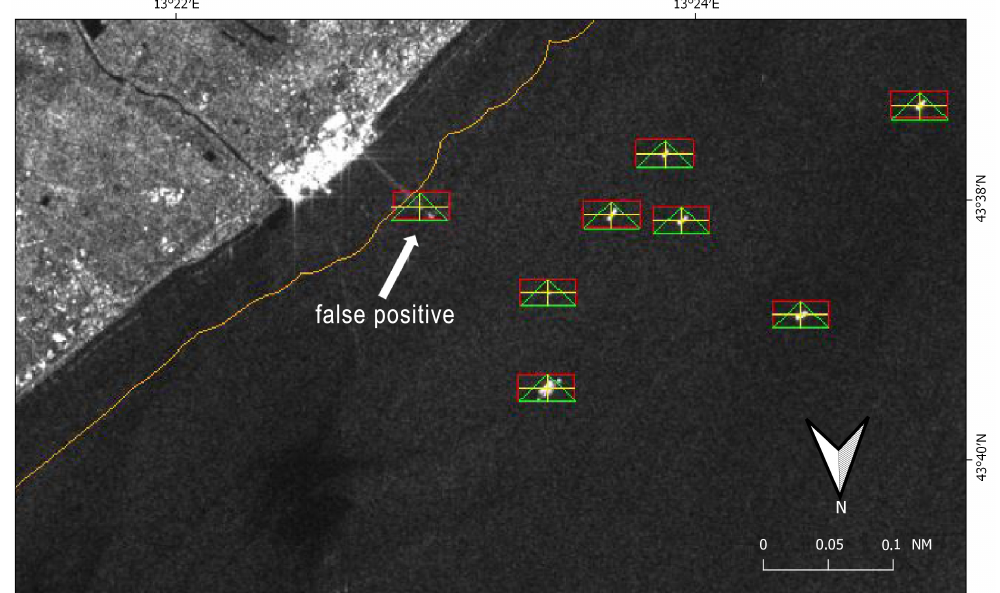
Figure 4. Target detection by SUMO on Sentinel-1 image (9 March 2020 at 05:11:14 UTC), VH channel. The orange line represents the 250 m buffer used by SUMO for land masking, while yellow crosses identify the centroids of the targets which result by merging detections in VH and VV bands (green triangles and red rectangles, respectively). In detail a false positive is shown due to a pier that was not masked by the 250 m